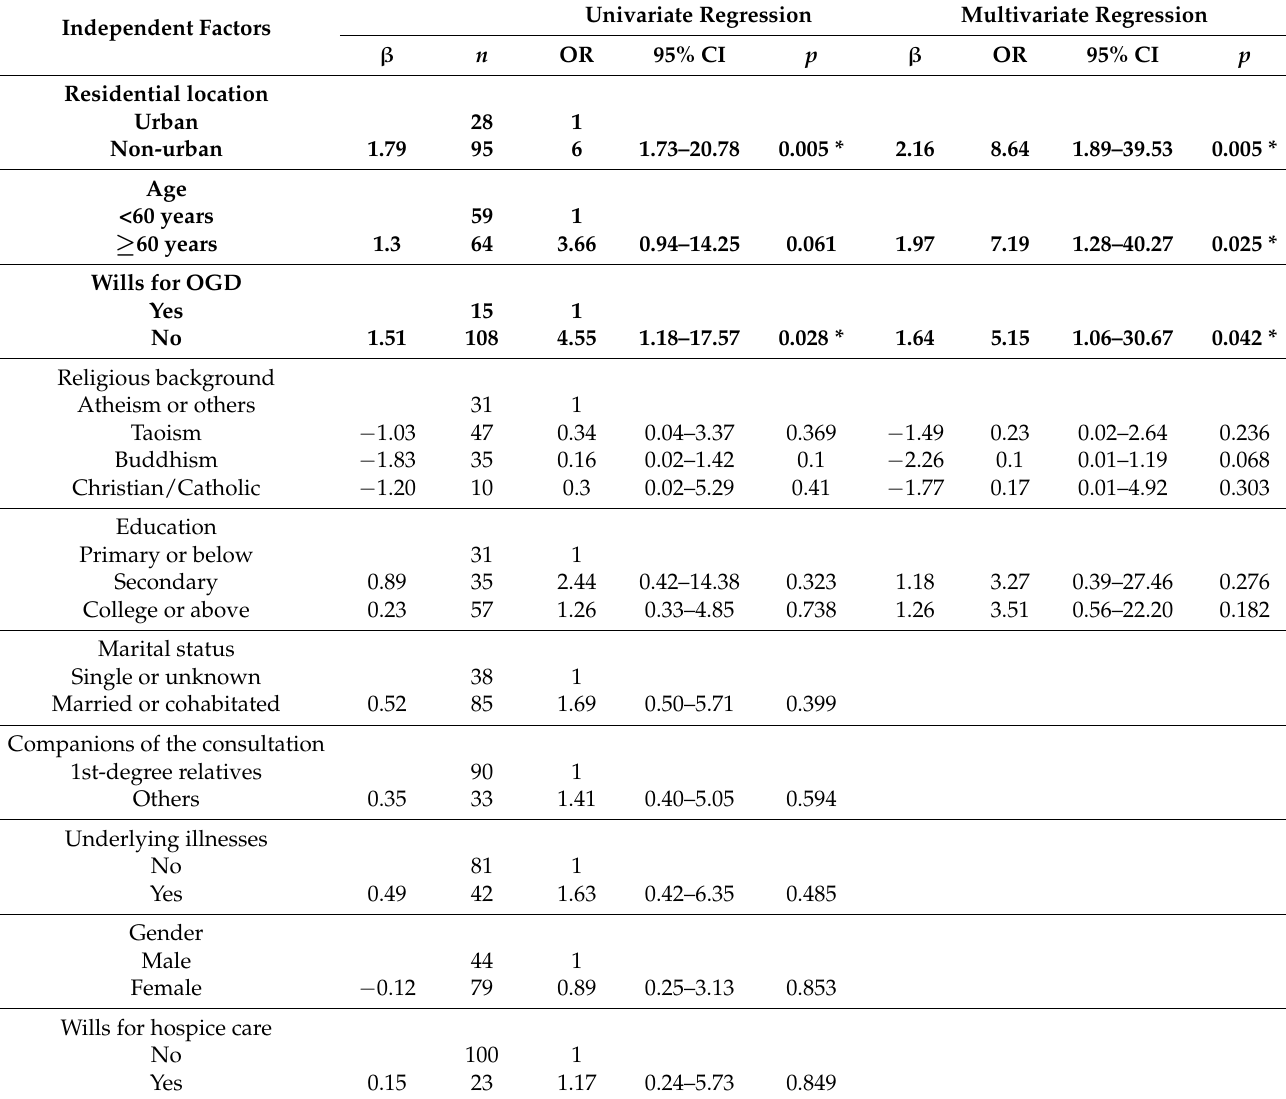
Table 4. Factors associated with refusing life-sustaining treatment or artificial